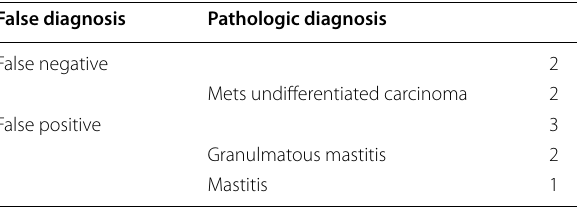
Table 6 False positive and false negative cases on CEDM False